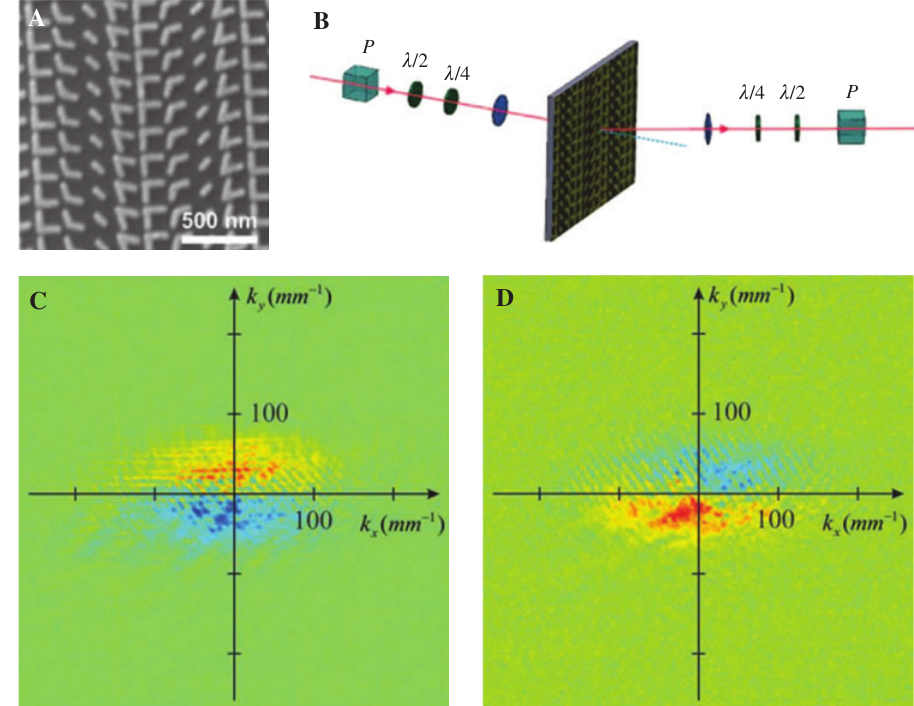
Figure 9: The photonic SHE related to spin redirection phase is directly observed by introducing an ultrathin metasurface. (A) The scanning electron microscope image of metasurface designed by arranging the V-shape antennas in x -direction. (B) The schematic illustration of the observing setup. (C) and (D) are the measured S when polarization of incident beam is changed from linear polarization in x direction to y 3 direction. Adapted from Ref.